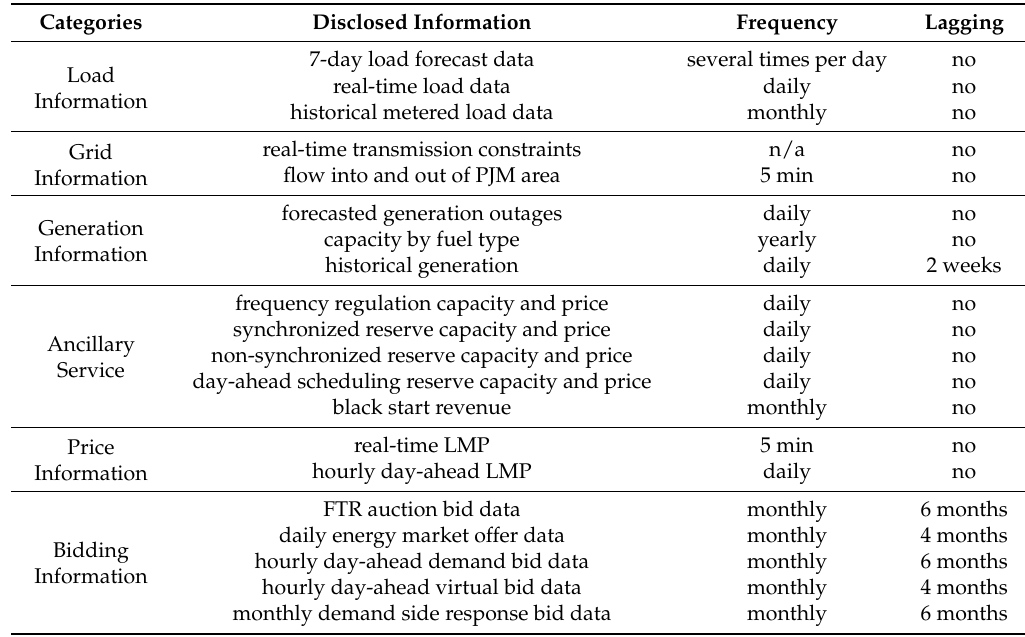
Table 2. List of information disclosed by PJM [37,38].